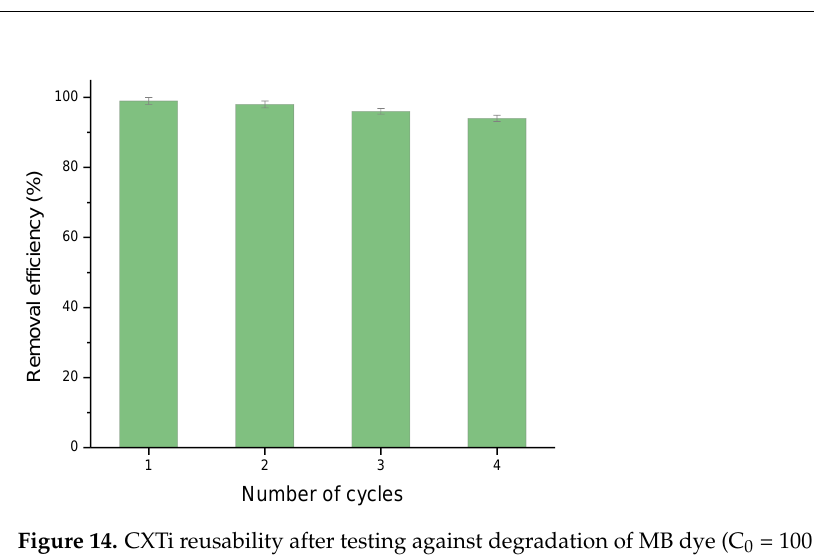
ticle diffusion model, corresponding to Figure 7. Figure S1. X-ray diffraction (XRD) spectrum of Carbon Xerogel (CX) indicating two broad diffraction peaks of CX at 2θ = 24° and 2θ = 44°, repre- sented by highlighted region in light grey. These findings are similar to previously described XRD pattern obtained for CX derived from resorcinol-formaldehyde [46,47]. Figure S2. X-ray diffraction spectrum of Carbon Xerogel/TiO2 (CXTi) indicating the presen ce of anatase phase at 2θ = 25°, rep- resented by highlighted region light grey. These findings are similar to previously described car- bon/titania systems [48].